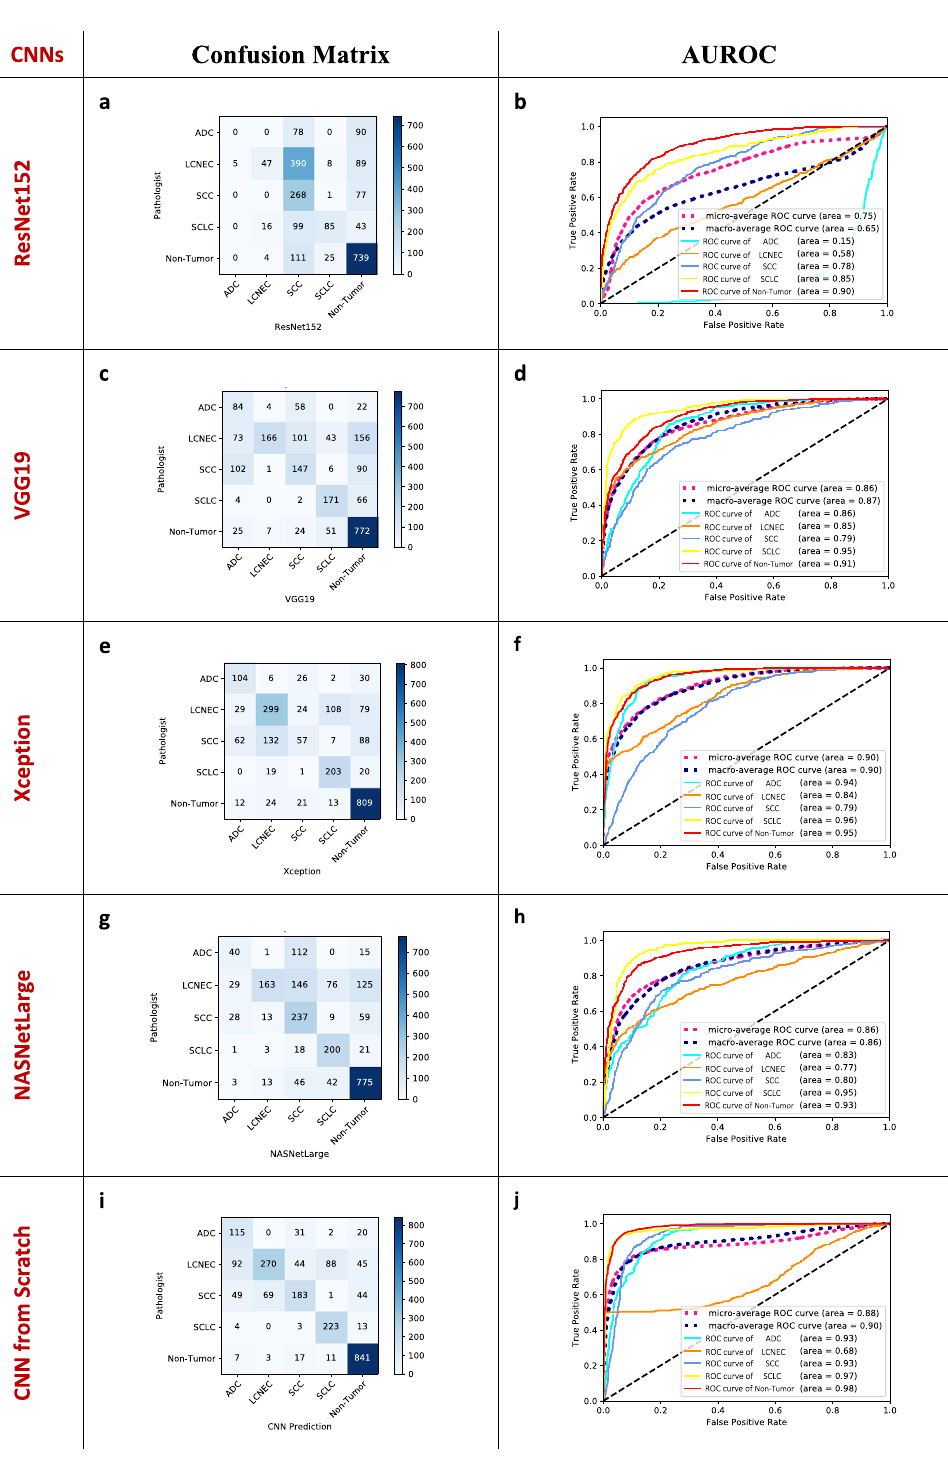
Figure 2. Confusion matrices and areas under the curve (AUC) for the receiver operating characteristic curves (ROC) achieved by the AI models for the multi-classification . To evaluate the performance of each multi- classification model, normalized confusion matrices ( a , c , e ) and areas under the curve (AUC) for the receiver operating characteristic curve (ROC) ( b , d , f ) were calculated for each model on the test set [ResNet152 ( a , b ), VGG19 ( c , d ), Xception ( e , f ), NASNetLarge ( g , h ), CNN from scratch ( i , j )]. Each row of each matrix represents the number of patches in a predicted class by the corresponding AI model, while each column represents the actual instances in each class according to